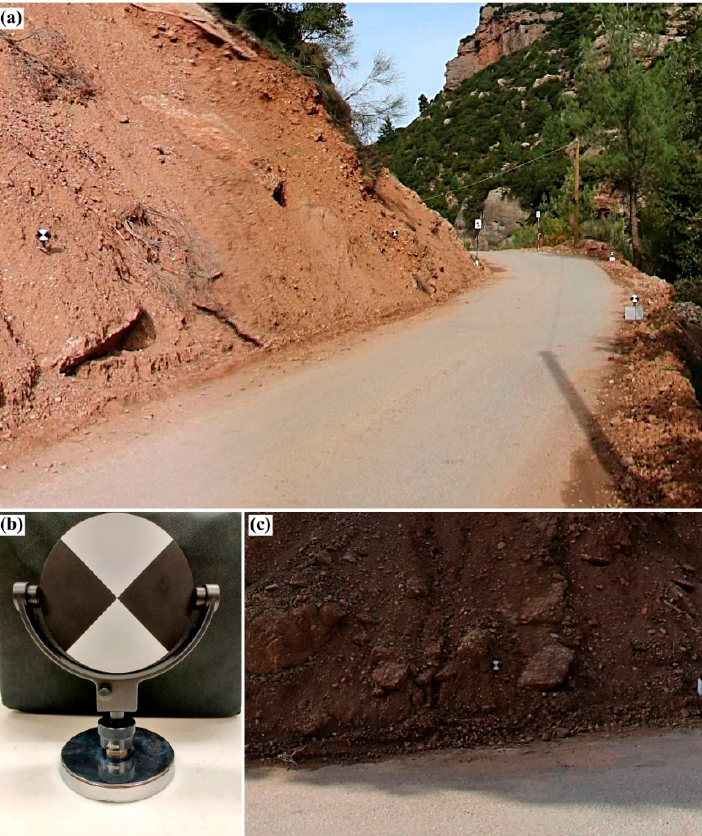
Figure 5. ( a ) Distribution of GCPs in the area of interest, ( b ) 4.5 ″ black and white target, ( c ) 4.5 ″ black and white target within the landslide area.